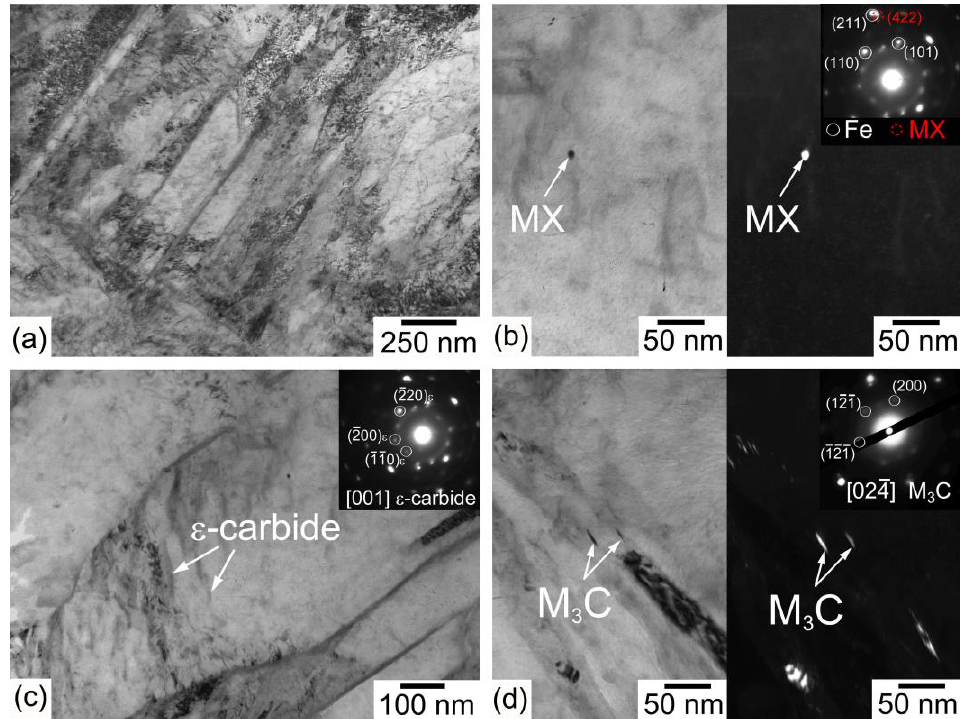
Figure 7. Typical microstructure of the 0.4%C-1.6%Si-1%Cr-0.95%Mo steel with V and Nb after quenching and tempering at 280 °C: TEM micrograph of martensite lath structure ( a ); TEM micro- graph of Nb(C,N) carbonitride within the lath ( b ); TEM micrograph of ε -carbide within the lath ( c ); TEM micrograph of cementite within the lath ( d ).